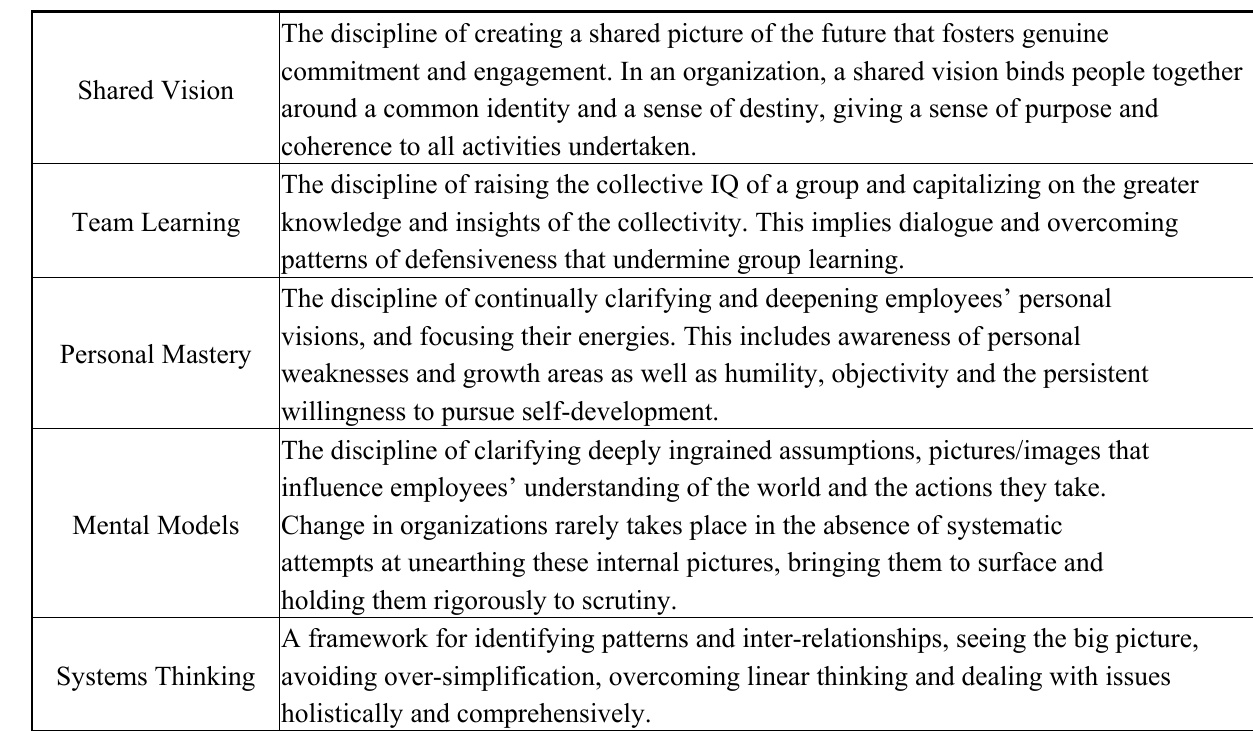
Table 1. Senge’s dimensions of a learning